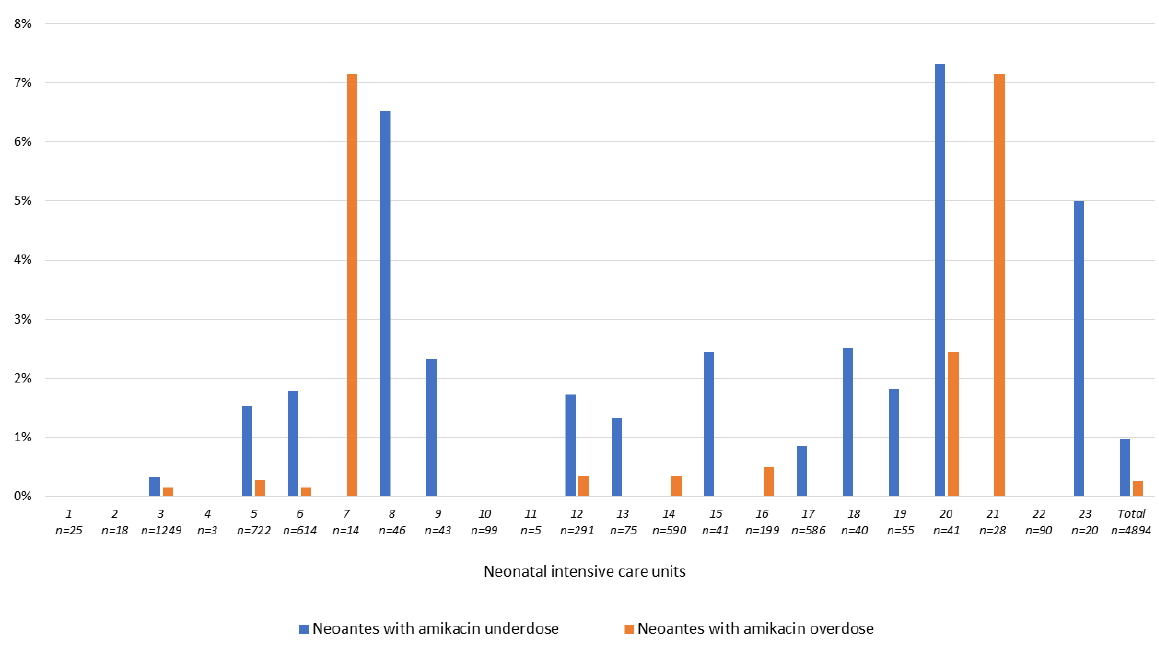
Figure 3. Proportions of neonates with at least one amikacin over-or-under-dosed prescription in 23 neonatal intensive care units.